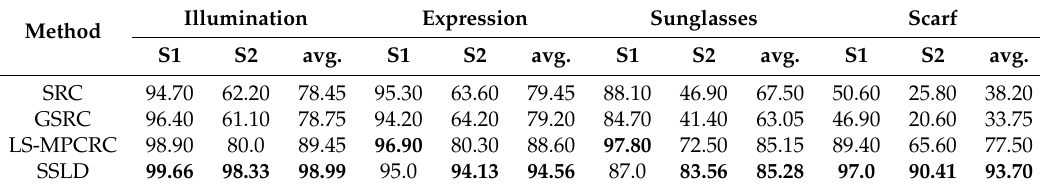
Table 3. Experiments on AR dataset and comparison with [23]. For each category (Illumination, Expression, Sunglasses, and Scarf) we report the recognition rate ( % ) for the sessions 1 and 2 (S1, S2), and the average performances (avg.). In bold we highlight the best performances.